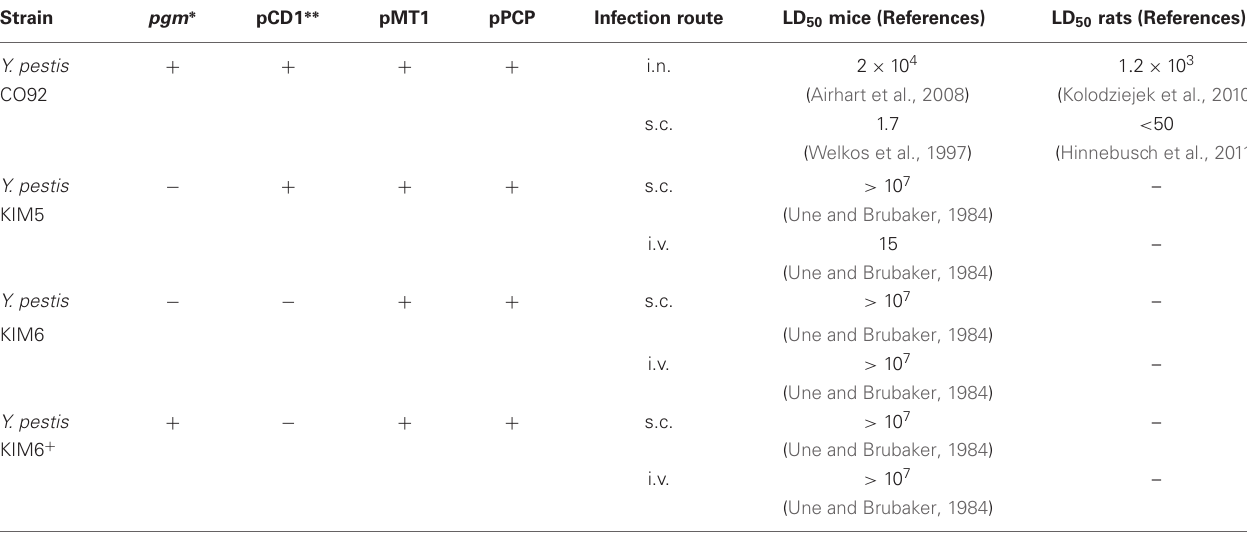
Table 1 | Characteristics and virulence of selected Y. pestis strains used in laboratory